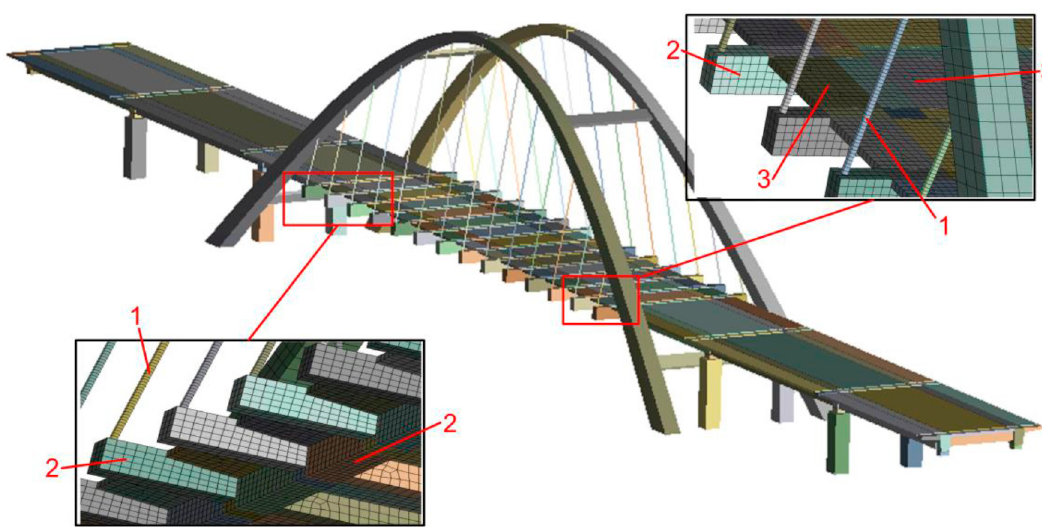
Figure 9. The numerical model, mesh detail, and finite elements used: 1—truss elements; 2—solid elements; 3—continuum shell elements.